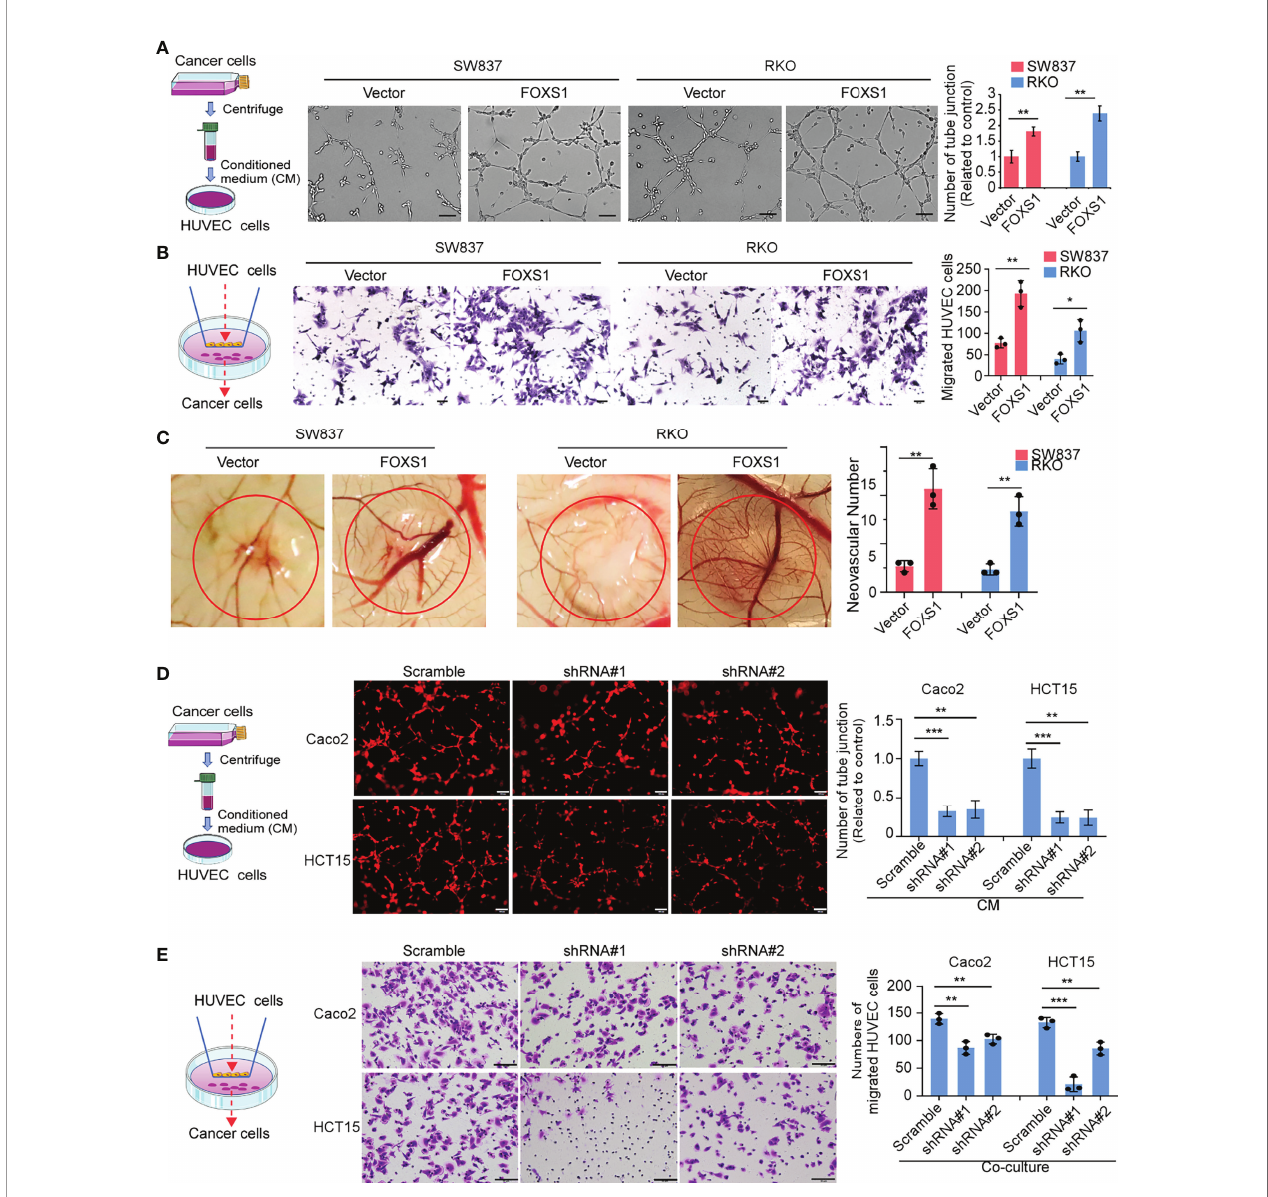
FIGURE 4 | FOXS1 is involved in tumor cell-induced angiogenesis. (A) HUVEC tube formation after stimulation with the indicated conditional medium from vector control CRC cells and FOXS1-overexpressed CRC cells. Scale bars: 50 µm. The number of tube junctions was calculated (right). (B) Migration of HUVECs toward conditioned medium from vector control CRC cells and FOXS1-overexpressed CRC cells. Scale bars: 50 µm. The number of migrated HUVECs was calculated. (C) Representative images of the CAM assay. Histograms show the formation of secondary and tertiary blood vessels after stimulation with the indicated conditional medium from FOXS1-overexpressing cells. (D) HUVEC tube formation after stimulation with the indicated conditional medium from FOXS1-depleted CRC cells. Scale bar: 50 µm. The number of tube junctions was calculated (right). (E) Migration of HUVECs toward conditioned medium from FOXS1-depleted CRC cells. The number of migrated HUVECs was calculated. Scale bar: 50 µm. * p < 0.05, ** p < 0.01, *** p <